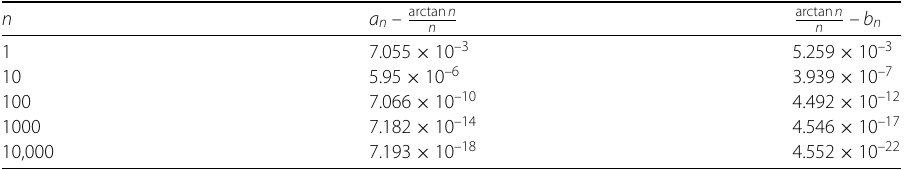
Table 1 Comparison between approximation formulas (3.5) and